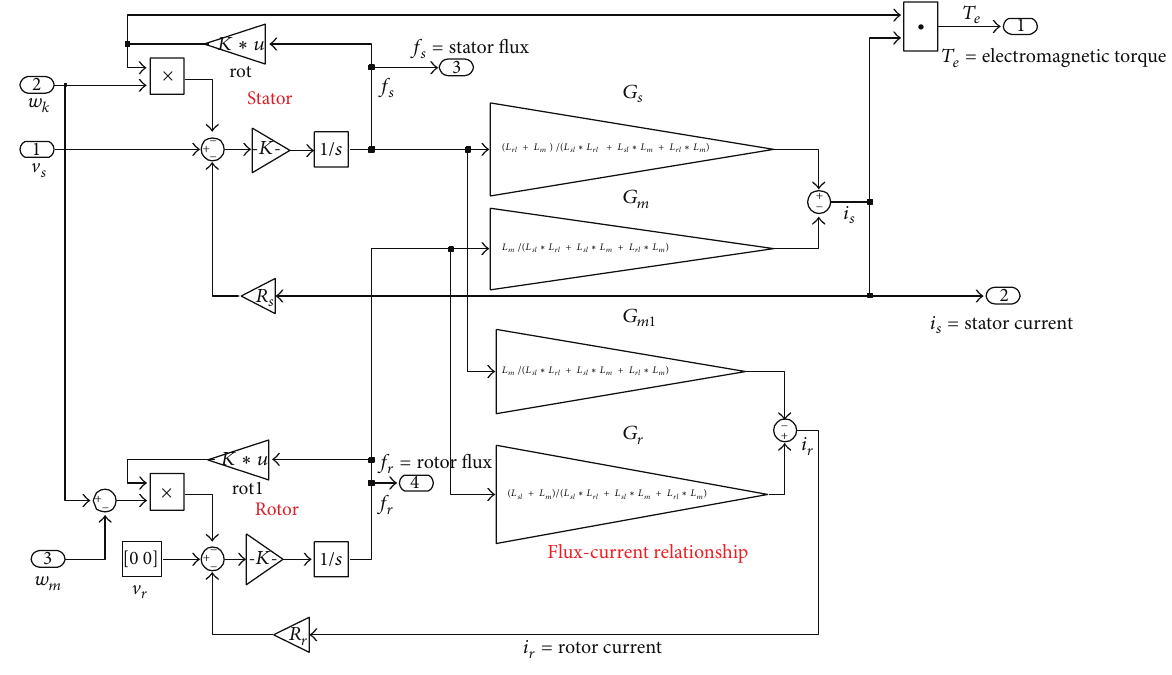
Figure 1: Induction motor modeling in arbitrary reference frame.